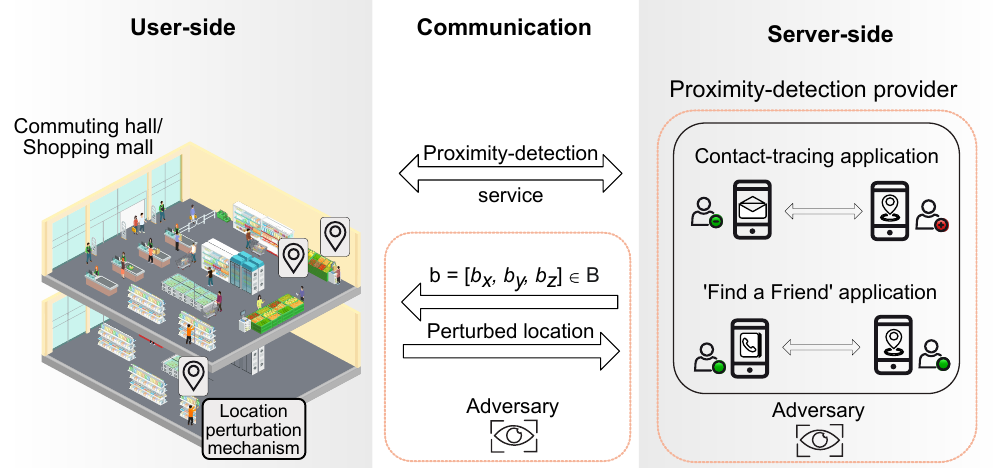
Figure 3. An illustration of the considered scenario: a building (e.g., a shopping mall) with users willing to use the digital contact-tracing and/or ‘find-a-friend’ applications. The ’Adversary’ entity refers to any third party which aims to access the information about devices’